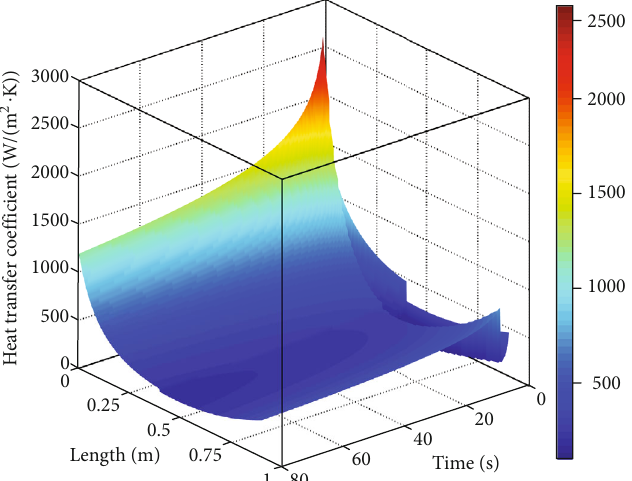
Figure 9: Convection heat transfer coe ffi